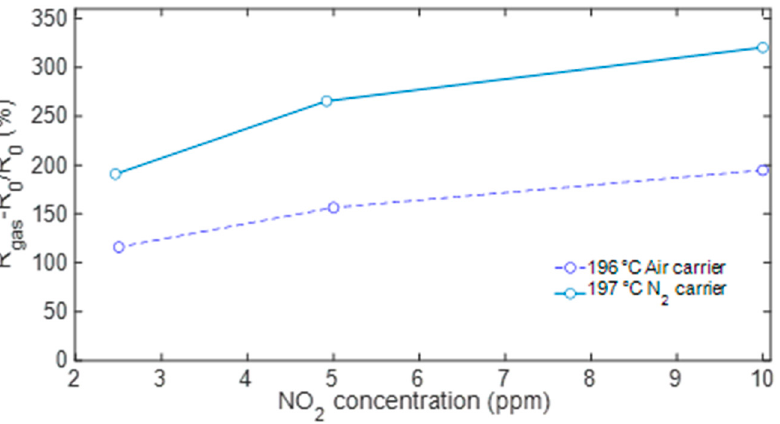
Figure 10. Sensor response to NO 2 with air (solid line) and N 2 (dashed line) as carrier gas evaluated at the optimal working temperature of 200 °C.